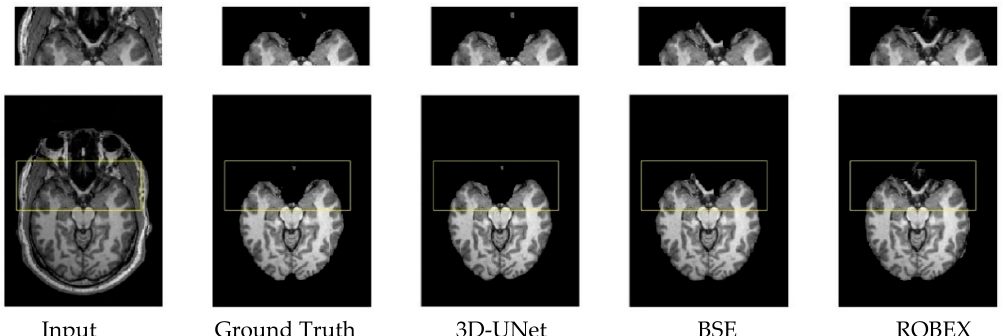
Figure 4. Skull stripping result on brain image of the eyes. 3D-UNet produced more accurate and smooth segmentation of the brain as compared to BSE and ROBEX. Segmentation failure regions (under or over-segmentation of the brain) are indicated with the rectangles, along with their zoom view.